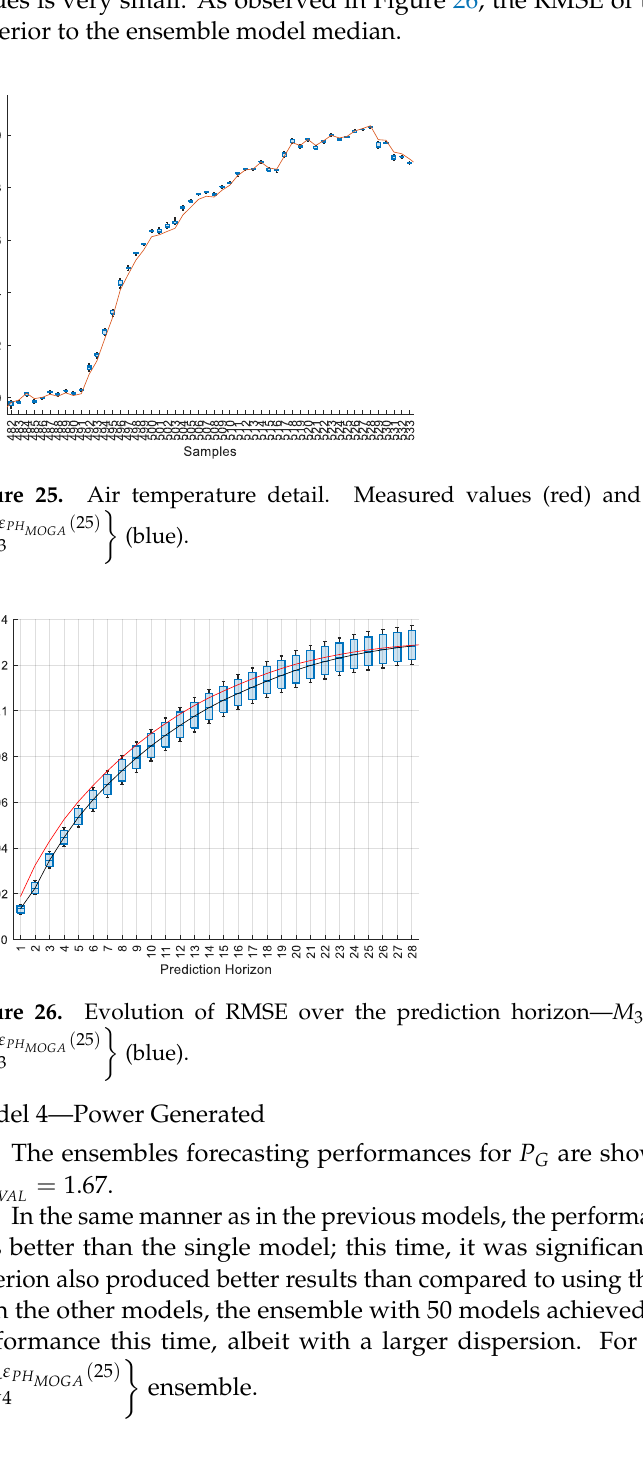
Table 9. Forecasting performances for M 4 .